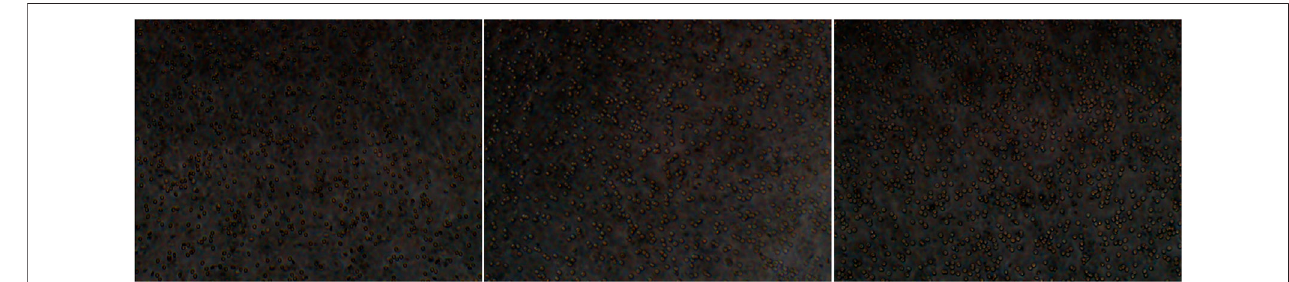
Frontiers in Pharmacology |